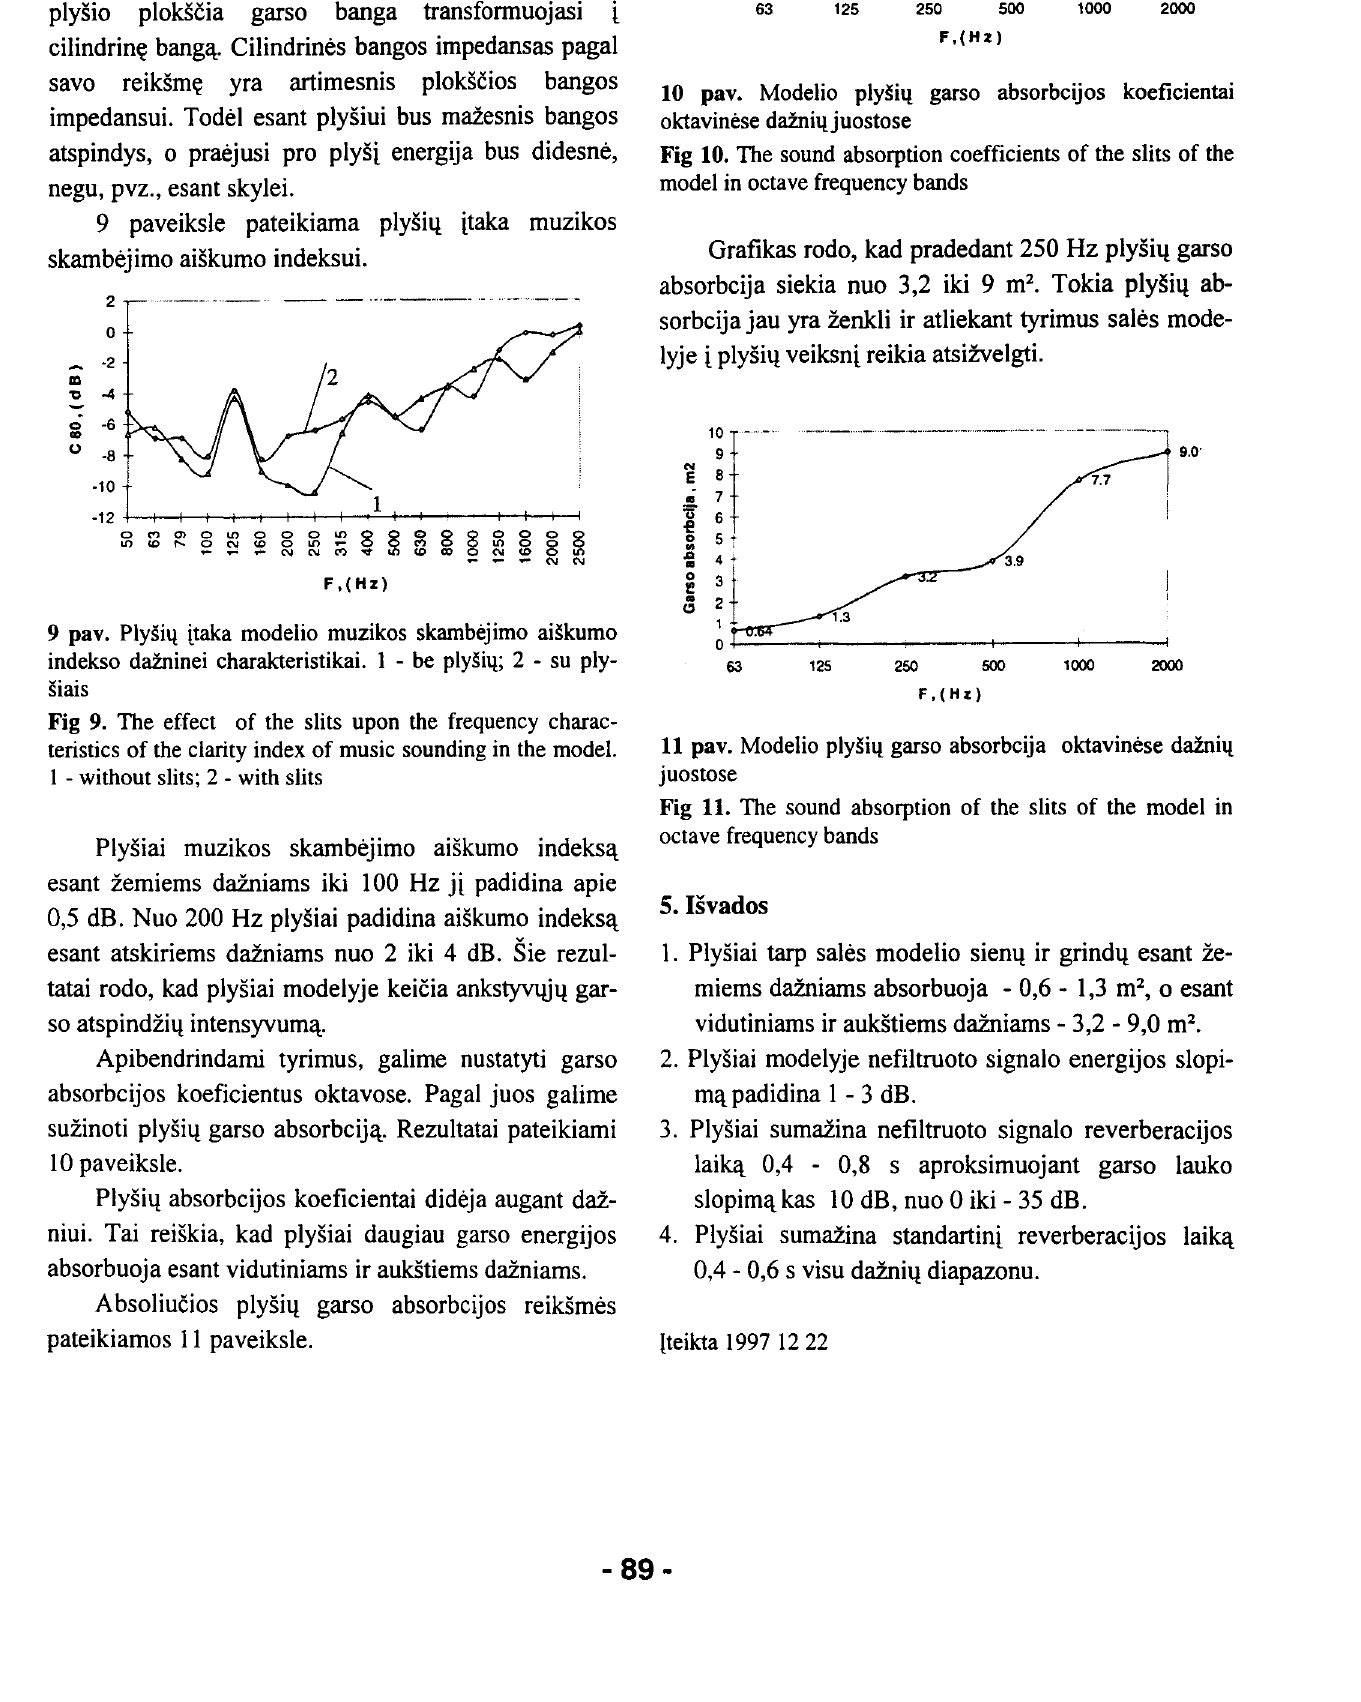
Fig 10. The sound absorption coefficients of the slits of the model in octave frequency bands